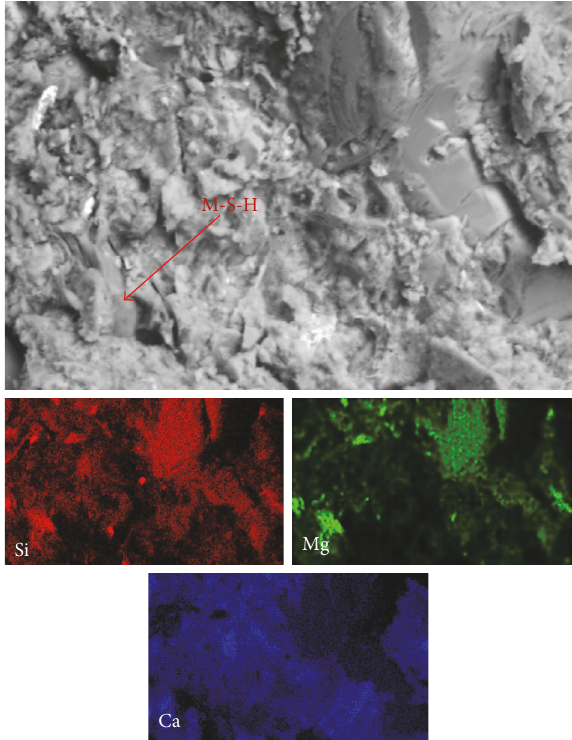
Figure 10: SEM image and its EDAX mapping on Si, Mg, and Ca of SCC-15.